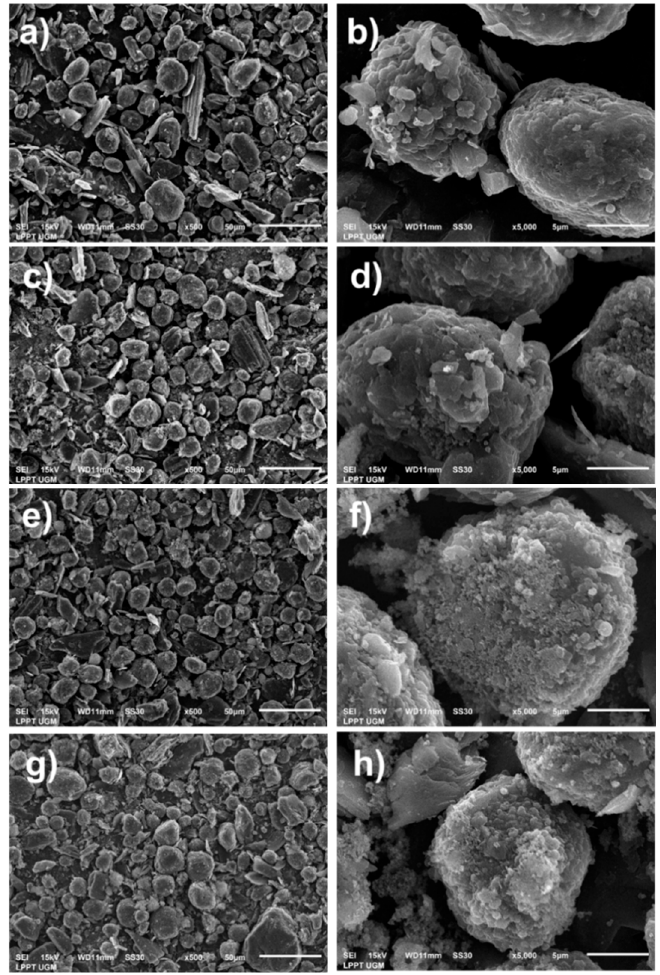
Figure 8. SEM images (500× and 10,000× magnification) of graphite ( a , b ) and 10% SiO 2 /C composite with heat treatment at ( c , d ) 400 °C, ( e , f ) 500 °C, and ( g , h ) 600 °C. with heat treatment at ( c , d ) 400 ◦ C, ( e , f ) 500 ◦ C, and ( g , h ) 600 ◦